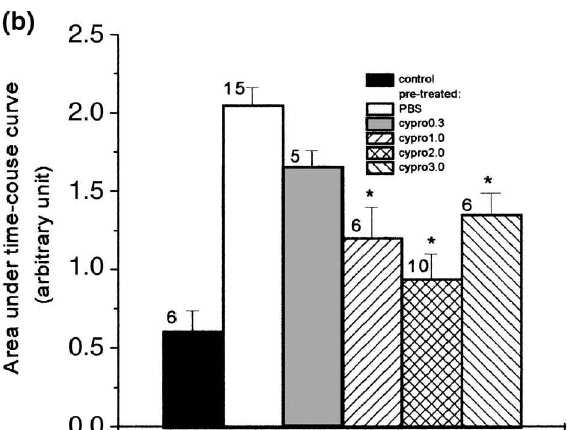
FIG. 3. Inhibition by diphenydramine (diphen; anti-H 1 ) of rat paw oedema induced by intraplantar injection of ovalbumin (ova; 10 m g/paw) in sensitized rats. Fourteen to 18 days before, animals were sham-sensitized (control) or sensitized with ovalbumin (30 m g/rat, i.p.) and treated 1h before intraplantar challenge, with PBS or diphenydramines.c. at the doses indicated. (a) Oedema was measured 1, 2, 3 and 4h after the inflammatory challenge and expressed as the increase in paw volume (ml) above its basal volume. (b) The area under the time-course curve was determined using a trapezoidal rule. Each point represents the mean ± SEM for the number of animals indicated. * Significant statistical differences compared with the PBS group ( p < 0.05; ANOVA, Student’s t -test).